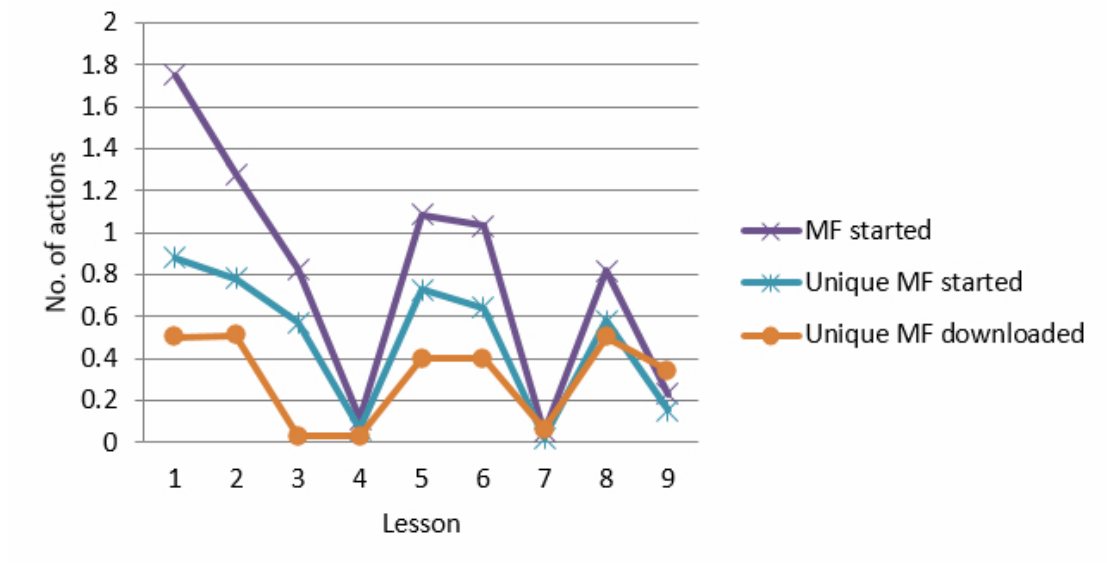
Figure 3. Mindfulness per